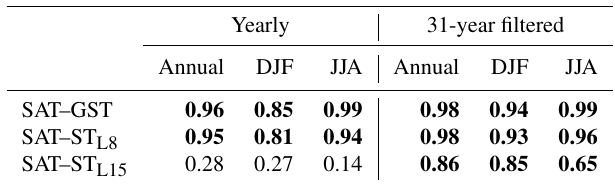
Table 4. Temporal correlation coefficients between last millennium SAT–GST, SAT–ST L8 and SAT–ST L15 anomalies relative to the 1850– 2005 mean for the experiment shown in Fig. 1. The left side indicates the correlation at a yearly resolution, whereas the right side shows 31-year low-pass filter outputs of SAT, GST, ST L8 and ST L15 for the annual, DJF and JJA time periods. Coefficients highlighted in bold are statistically significant at p < 0 .